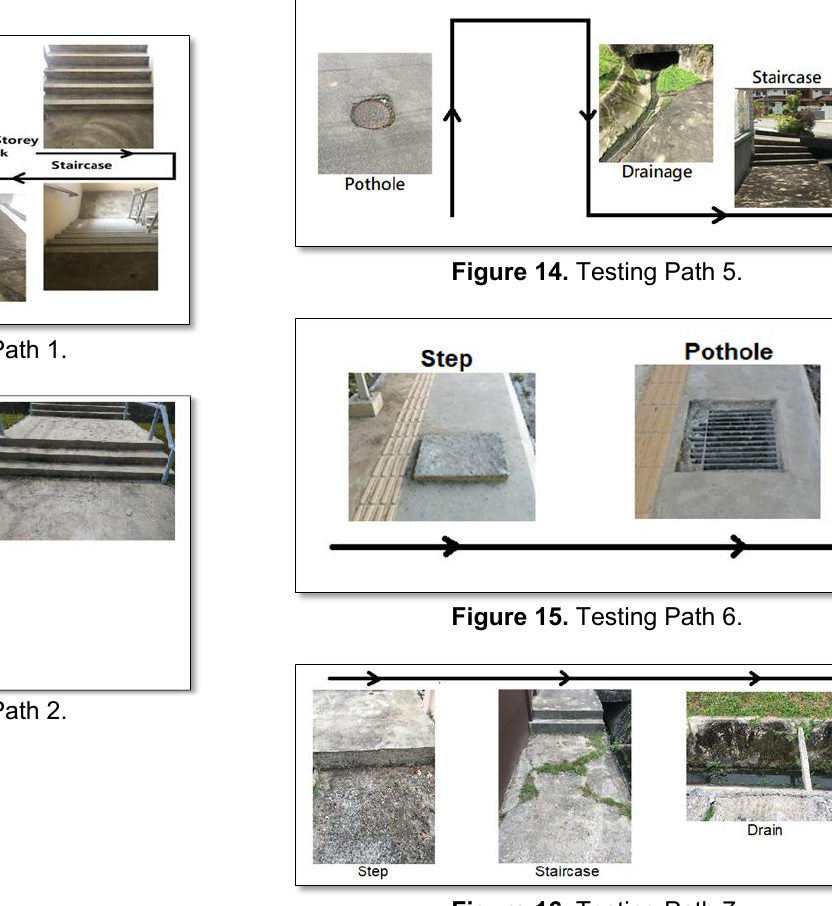
Figure 16. Testing Path